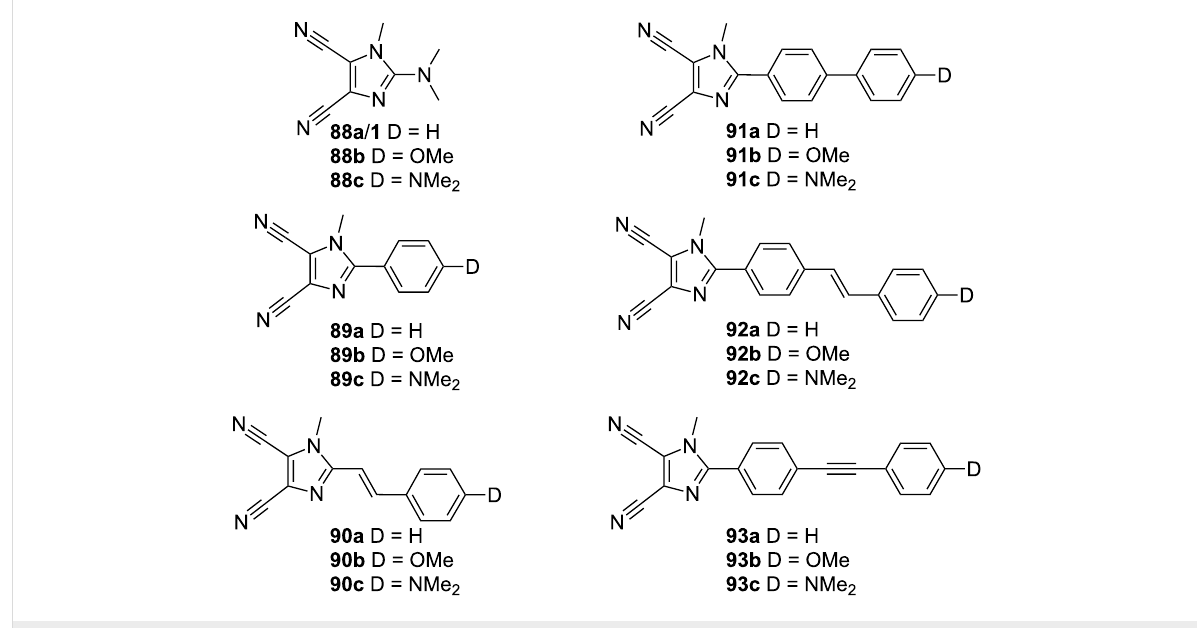
Figure 16: Push–pull chromophores 88 – 93 with systematically extended π -linker [30].